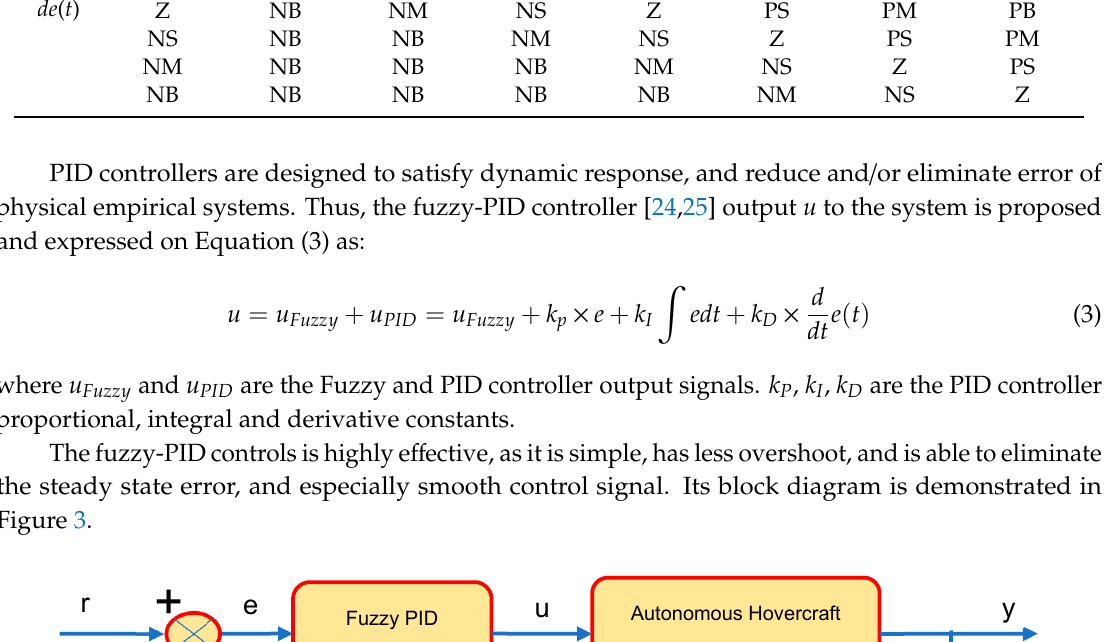
The optimal process of the modified GA to Fuzzy-PID control parameters using the ISE (integral of square errror) fitness function is formulated as ISE =